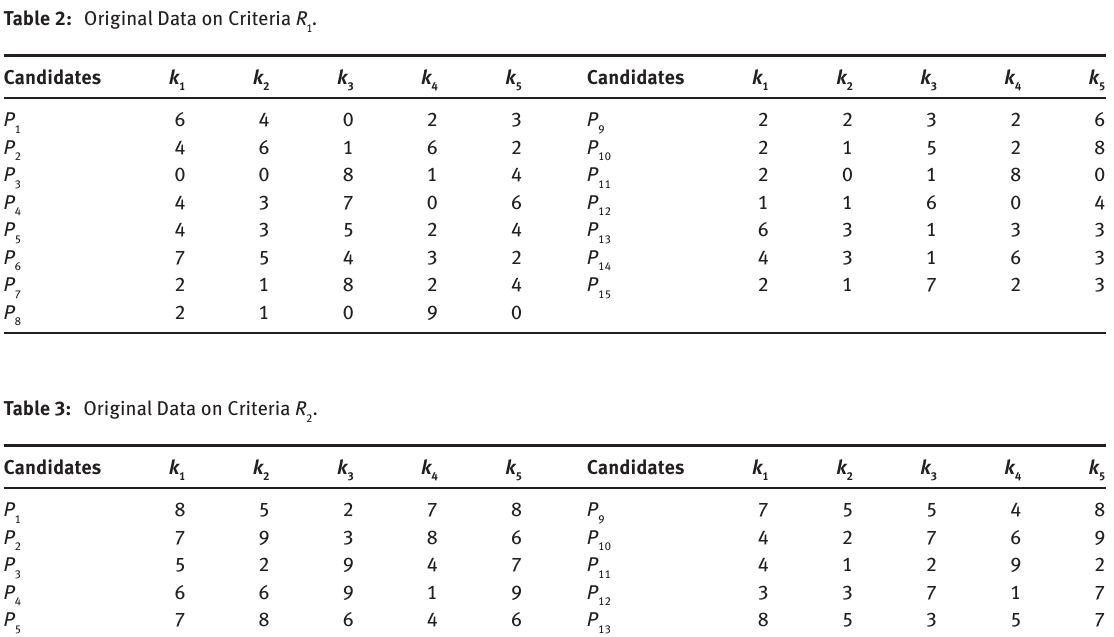
Table 2: Original Data on Criteria R